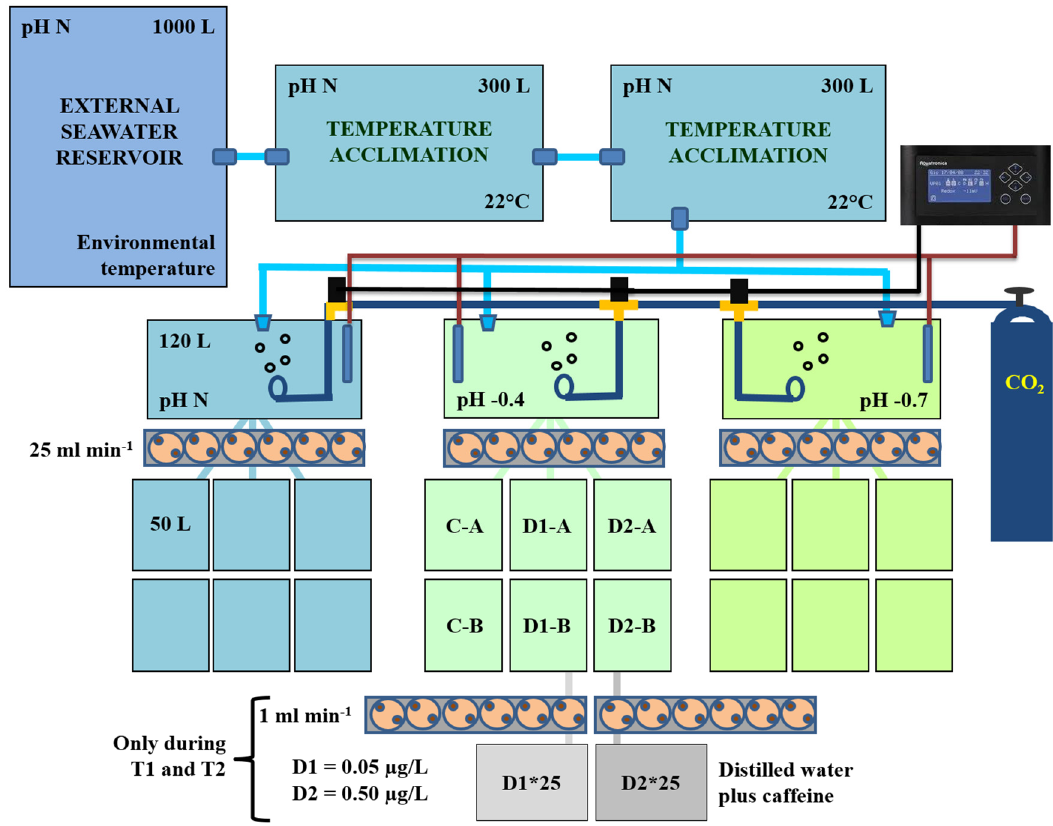
Figure 1. The experimental flow-through system.